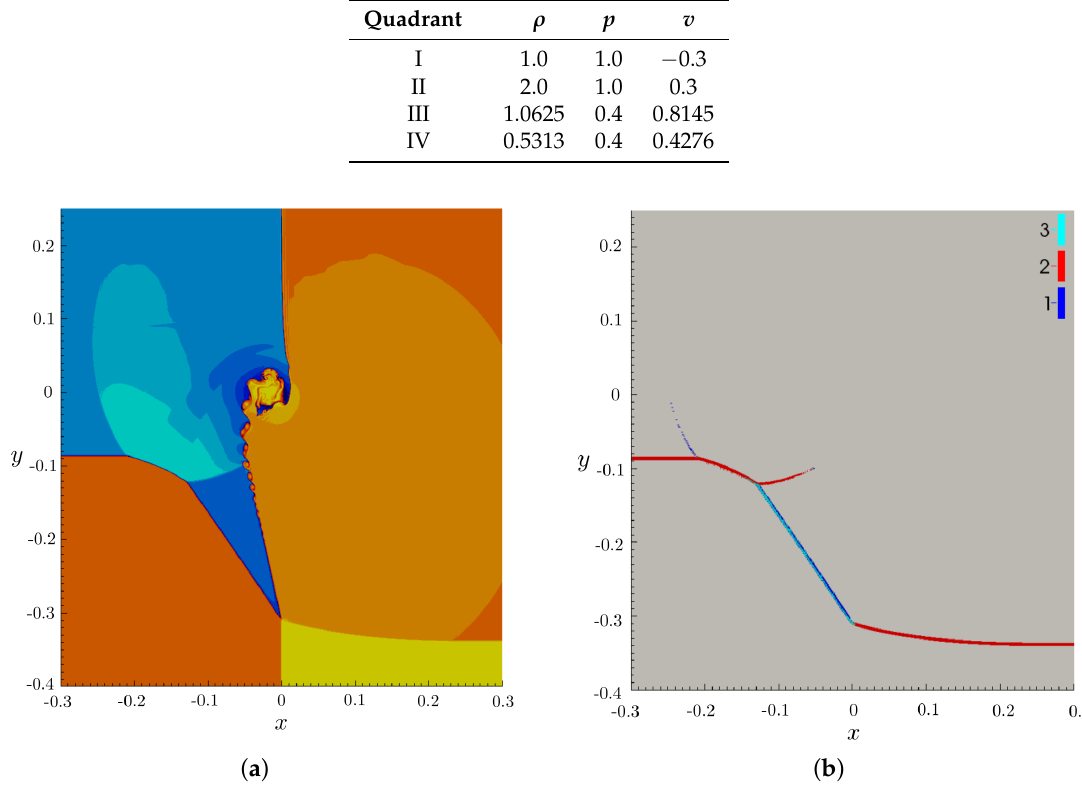
Figure 5. Solution at t = 0.3 for Case 13 by Lax and Liu [27], and filter adaptation: ( a ) Density; and ( b ) Filter adaptation ((3) ( cyan ) adapted along x and y ; (2) ( red ) along y only; and (1) ( blue ) along x